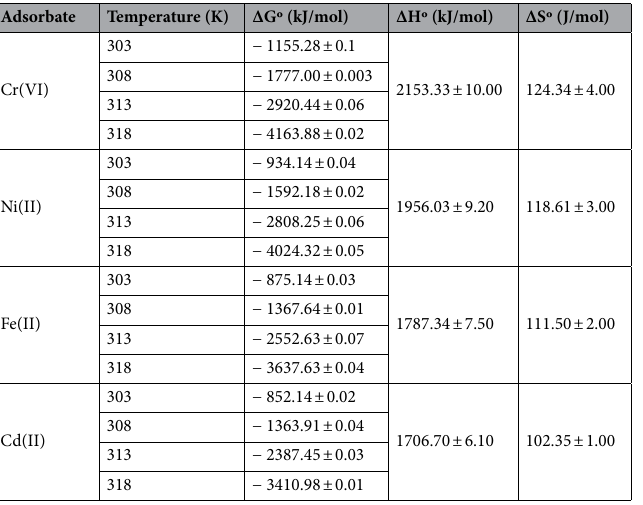
Table 5. Thermodynamic parameters for Cr(VI), Ni(II), Fe(II) and Cd(II) adsorption by